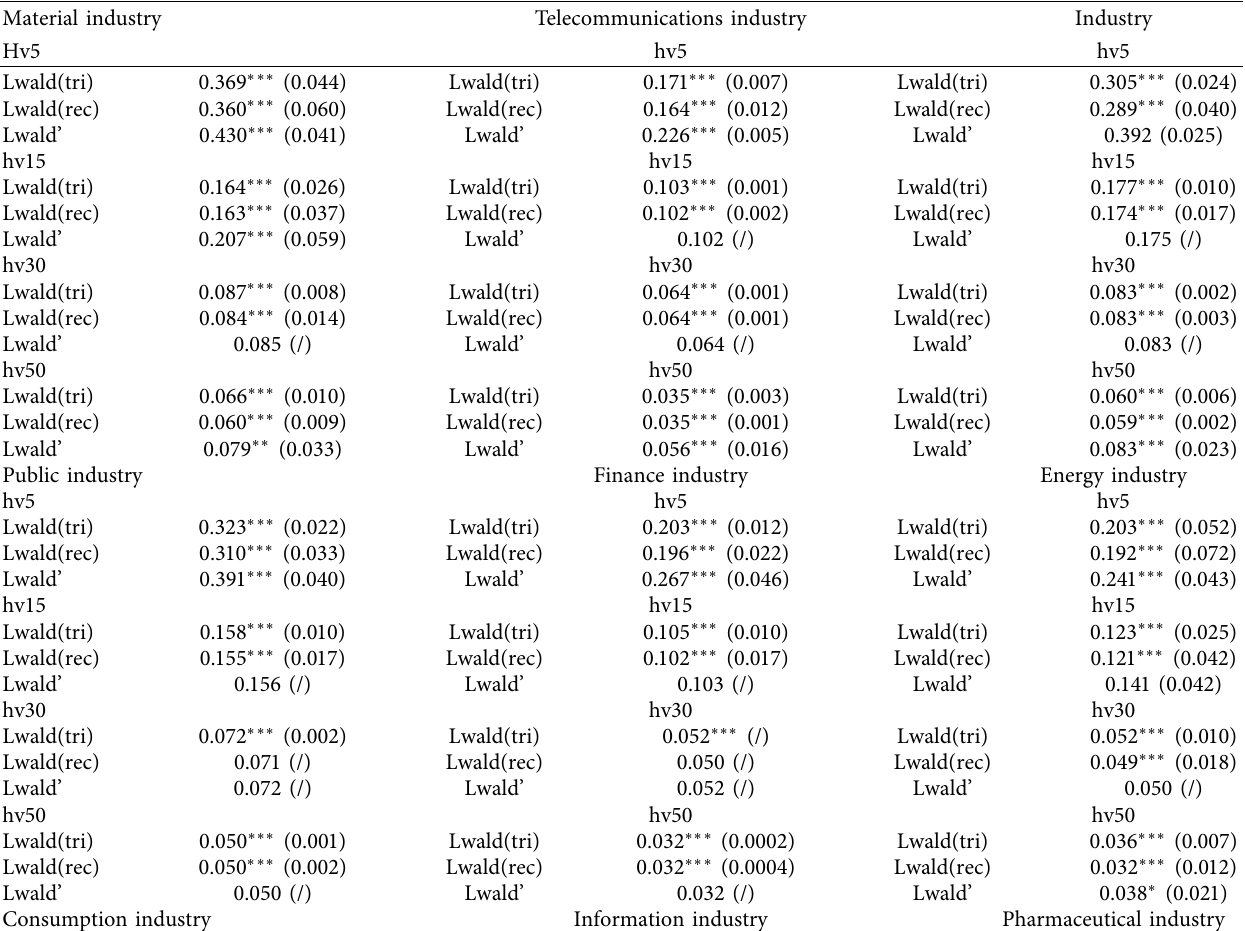
Table 3: RDD results for nine industries under the optimal